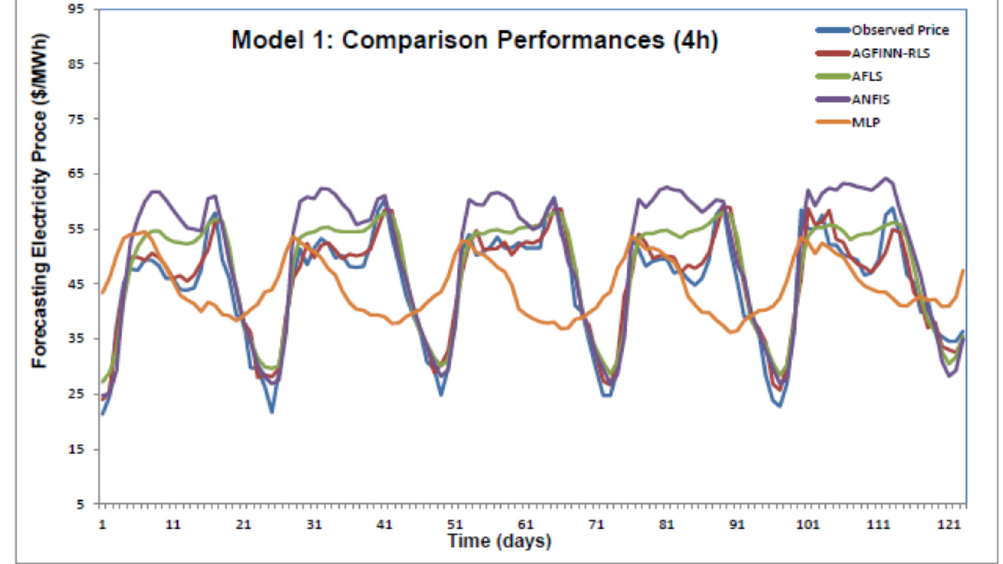
Figure 8. Forecasting for electricity price at 04:00—case study 1. Table 1. Statistical performance for electricity price forecasting models at 22:00—case study 1.